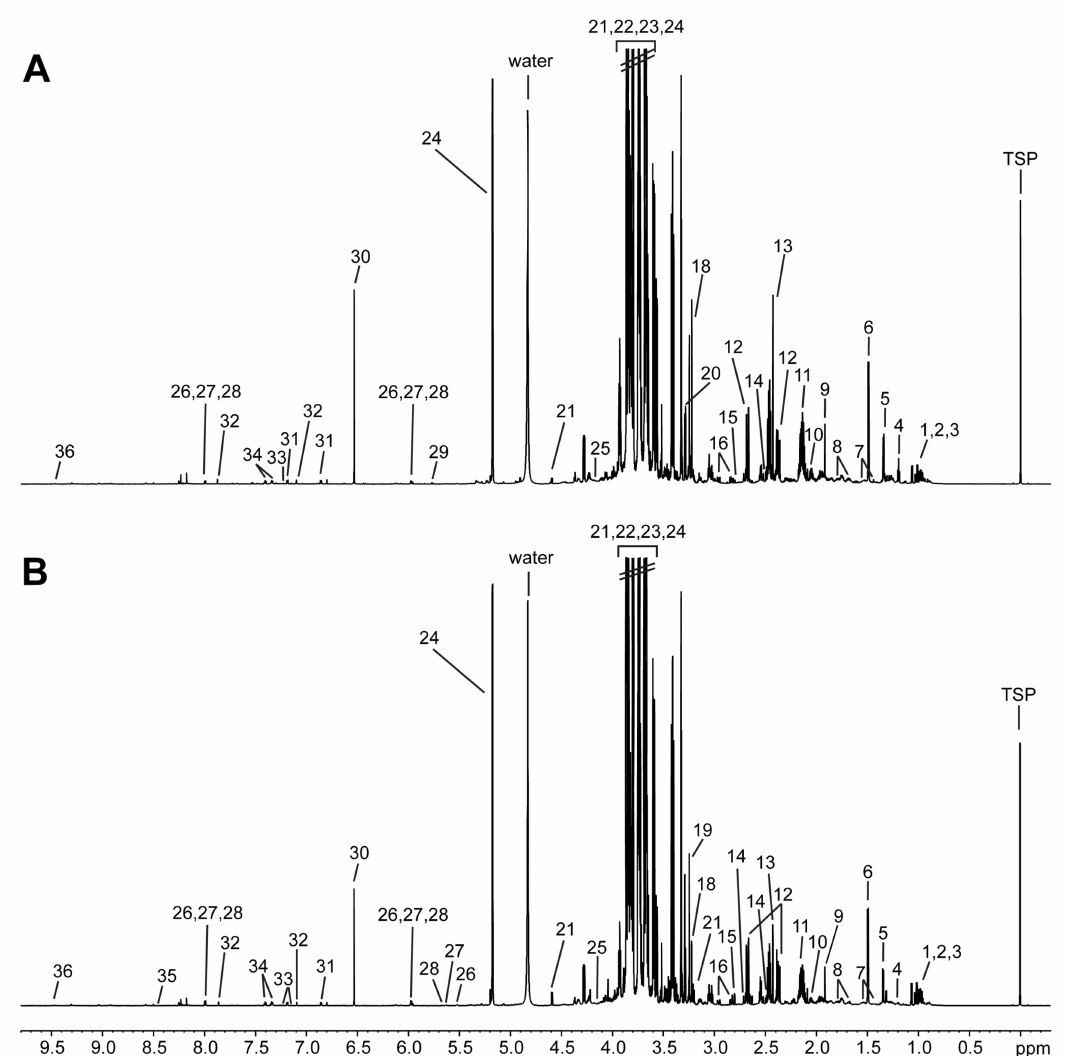
Figure 1. Representative 1 H NMR spectra of L. edodes extracts cultivated on ( A ) log bed and ( B ) sawdust